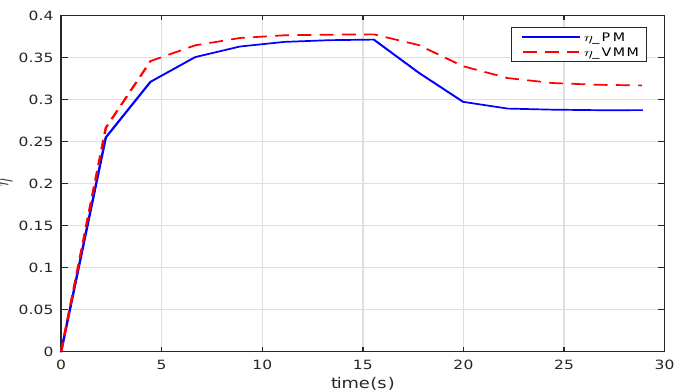
Figure 11. The efficiency of robotic fish in steady